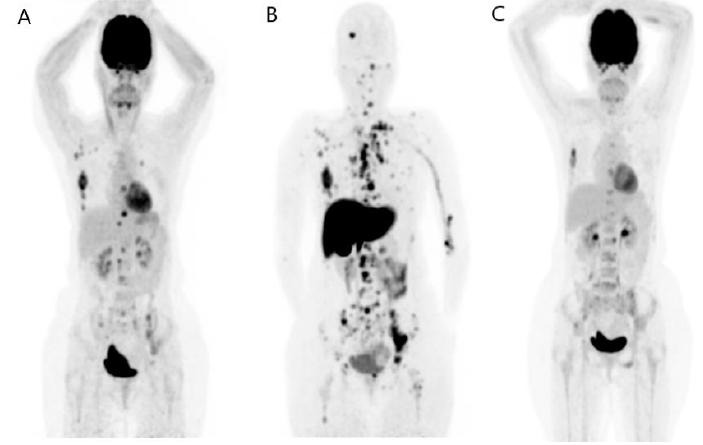
Figure 6. FES PET/CT in treatment guidance. A 50-year-old woman was diagnosed with BR eight years ago and treated with surgery, chemotherapy, and radiotherapy. A recurrence was detected by FDG PET/CT ( A for MIP image). As the tumor was initially RH+, treatment with fulvestrant was considered. A FES PET/CT was performed prior. Its MIP image ( B ) shows all lesions FDG+ were FES+ and it detected other FDG- lesions. At the evaluation of fulvestrant’s treatment response 3 months later, the FDG PET/CT ( C for MIP image) shows an important partial metabolic response.